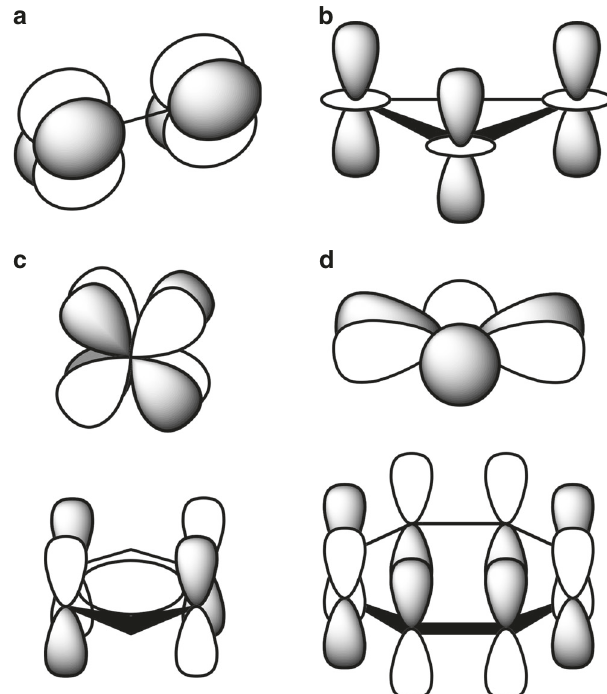
Fig. 1 Schematic representation of AOs comprising δ and φ bonds. a M – M δ interaction between two d xy (or d – M – M δ interaction among x 2 (cid:1) y 2 ) AOs. b M three d z 2 AOs. c “ head-to-head ” M – L δ interaction between f xyz (or f y ð x 2 (cid:1) z 2 Þ ) AO of metal (top) and unoccupied ligand orbital (bottom). d “ side-to-head ” M – L φ back-donation interaction between f x ð x 2 (cid:1) (or f y ð ) AO of metal 3 y 2 Þ 3 x 2 (cid:1) y 2 Þ (top) and unoccupied ligand orbital